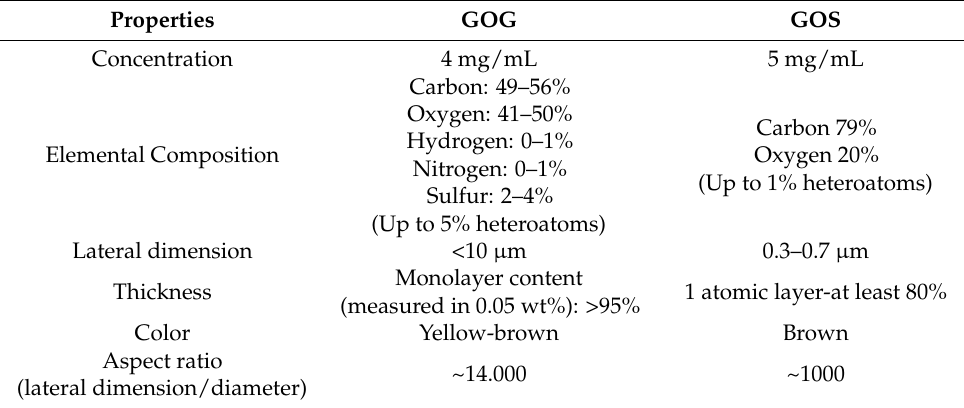
Table 1. Properties and elemental analysis of GOG and